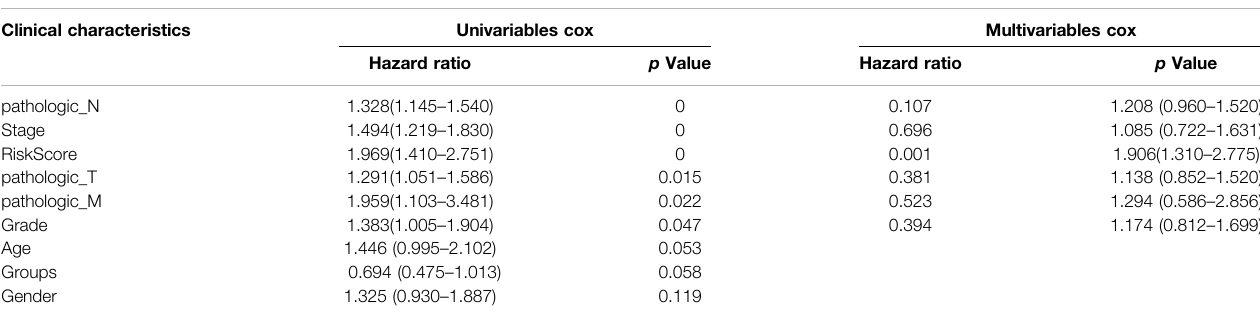
TABLE 3 | Univariate and multivariables Cox regression analysis for clinical factors. Clinical